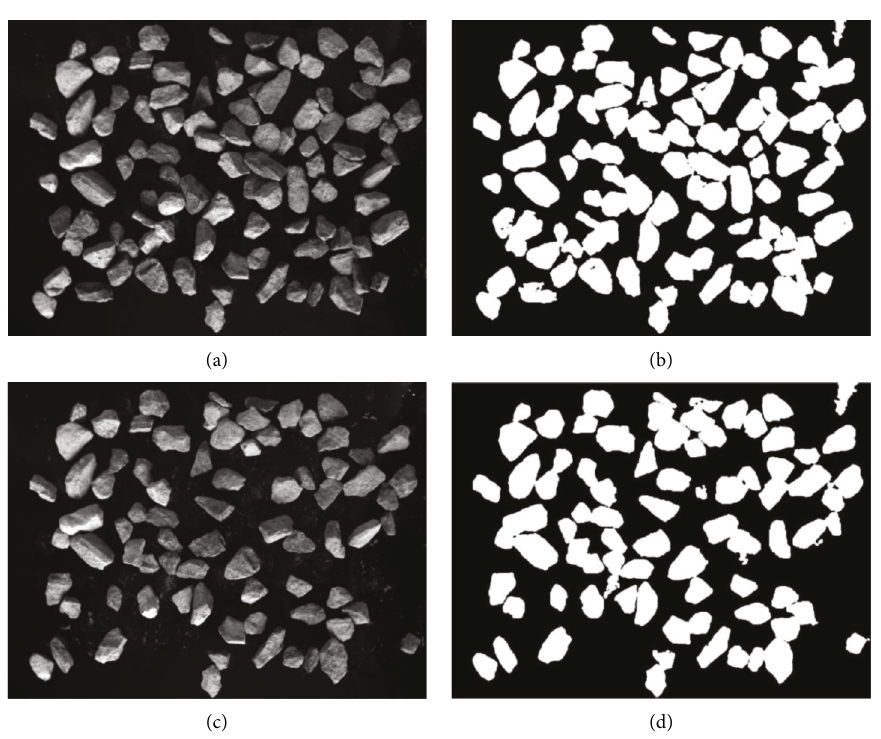
Figure 13: 9.5-13.2mm original image and inspection